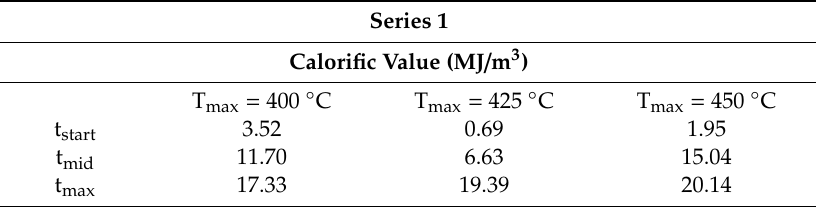
Table 8. Calorific value of the process gases at di ff erent temperatures, series 1.